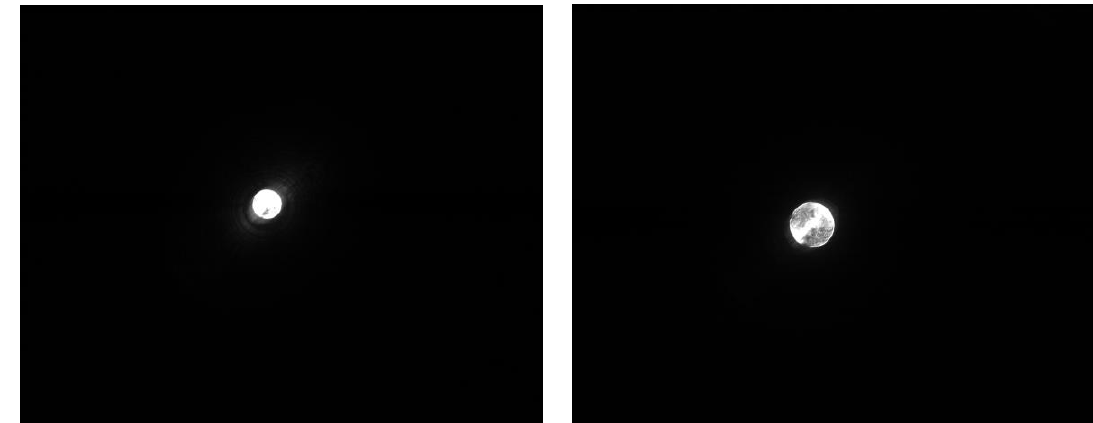
Figure 11. Difference between neutral z -axis ( left ) and pressed z -axis ( right ).